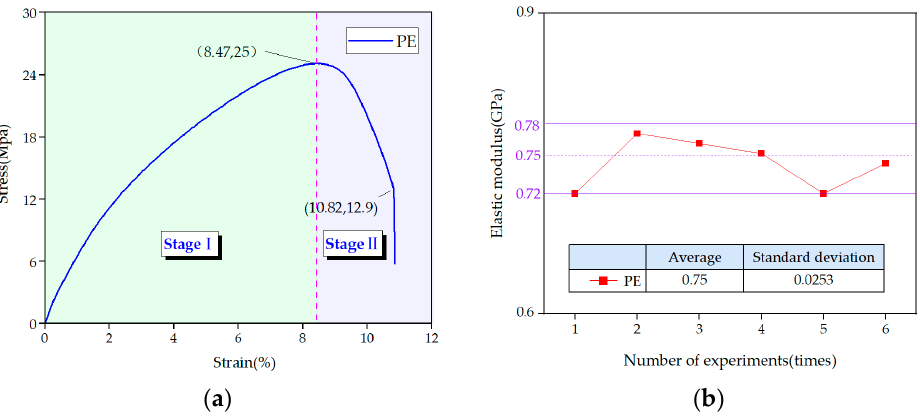
Figure 7. Tension of the polyethylene geogrid belt: ( a ) stress–strain curve of polyethylene geogrid belt; ( b ) distribution characteristics of the elastic modulus of the polyethylene geogrid belt.